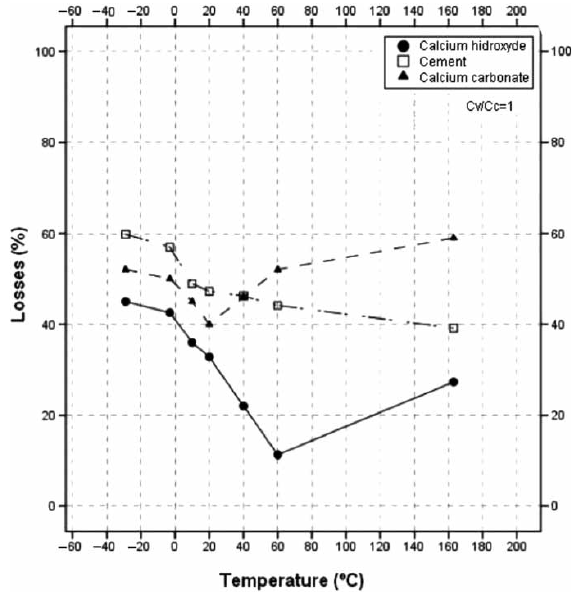
Fig. 4. Losses produced for each filler in a period of 40